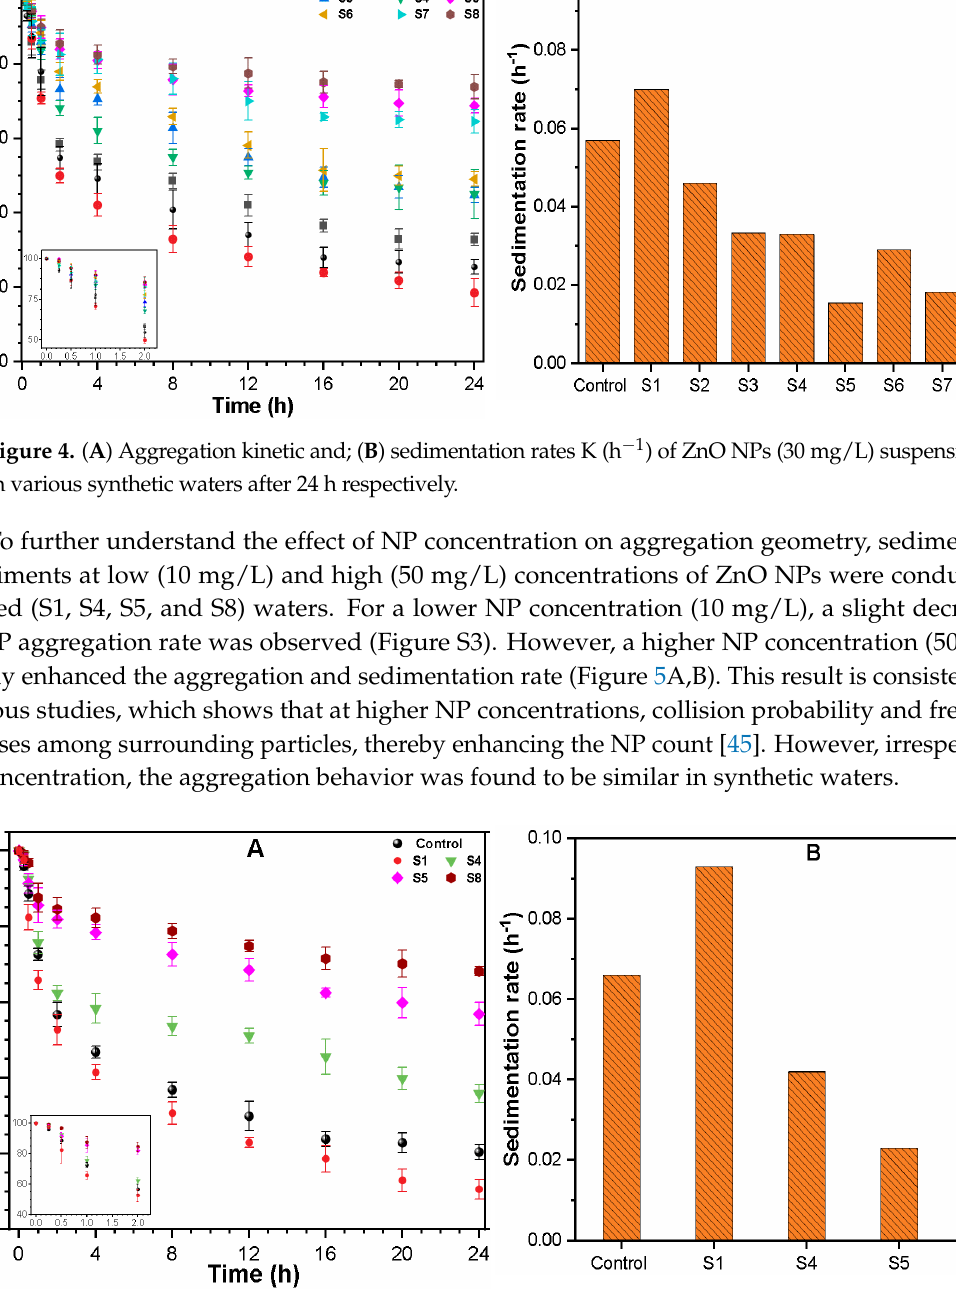
Figure 5. ( A ) Aggregation kinetic and; ( B ) sedimentation rates K (h − 1 ) of ZnO NPs (50 mg/L) suspension in selected synthetic waters after 24 h respectively.